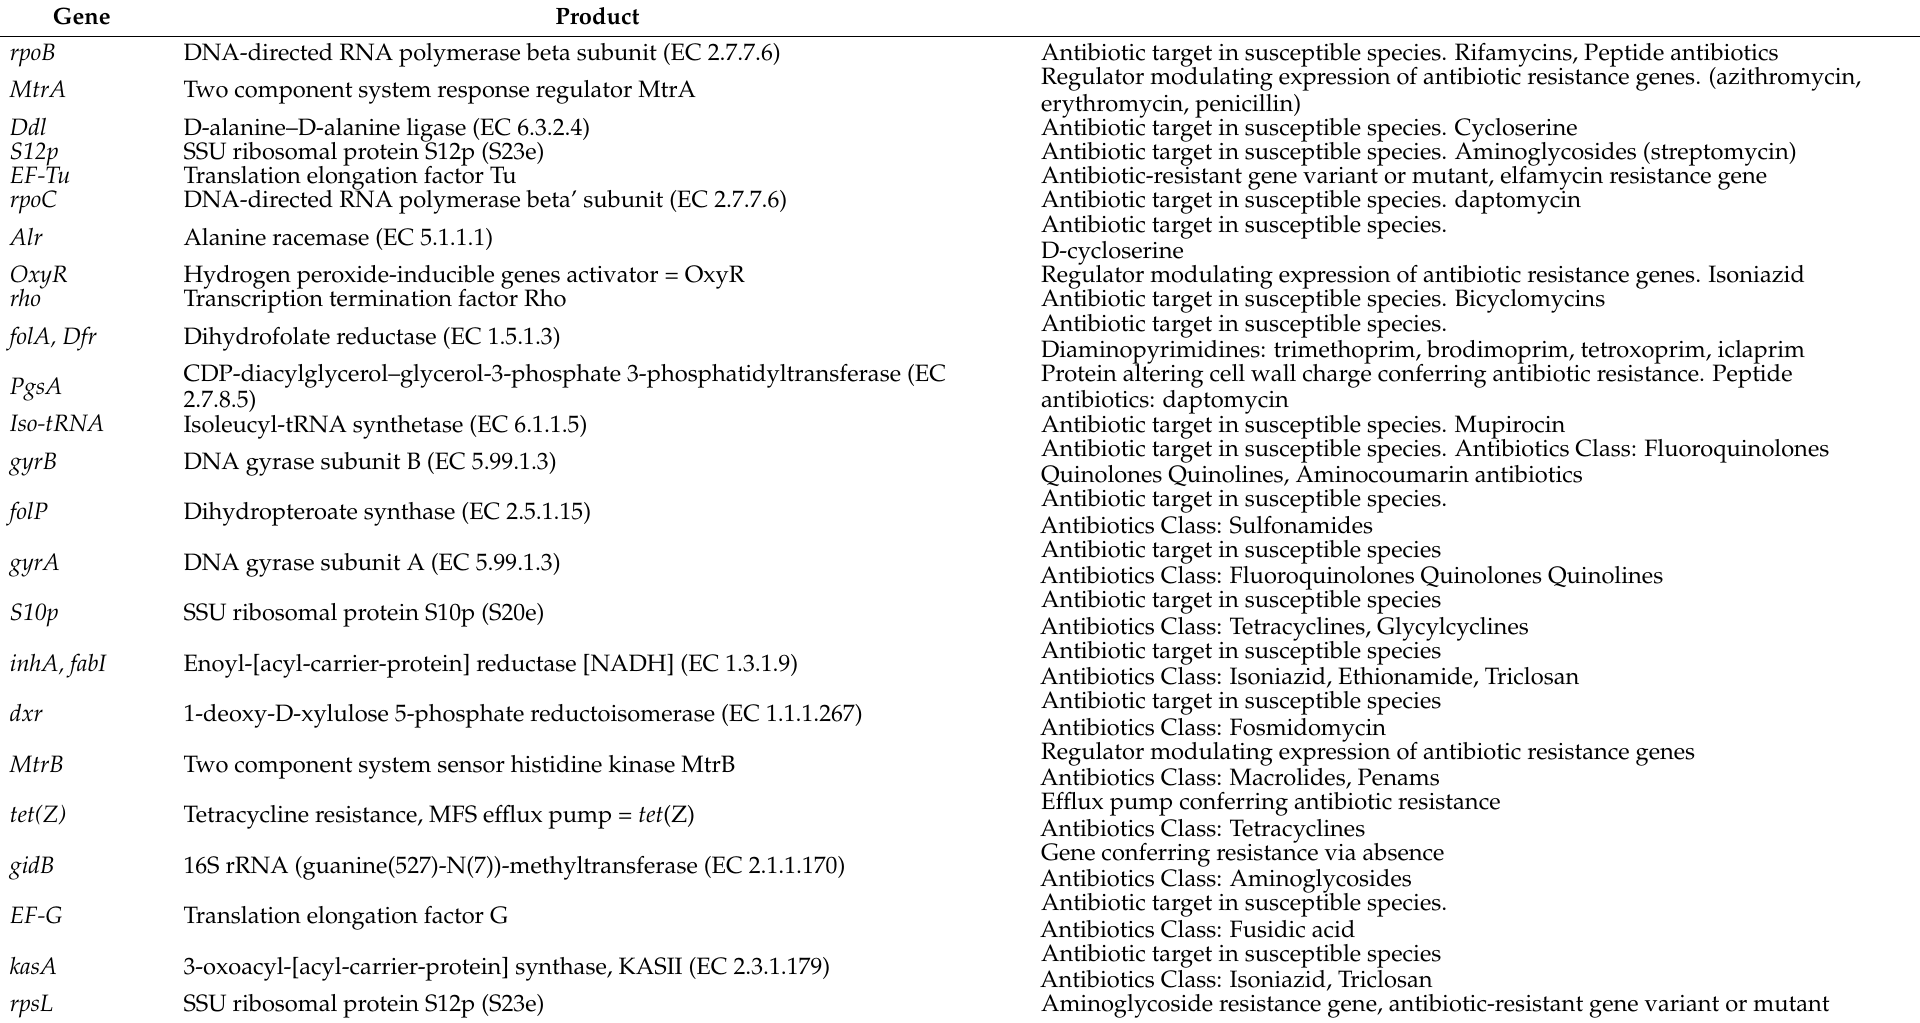
Table 2. Antibiotic resistance mechanisms and associated genes detected in the 40 genomes of D. congolensis isolated from different locations on the Island of St. Christopher in the West Indies. Gene Product rpoB DNA-directed RNA polymerase beta subunit (EC